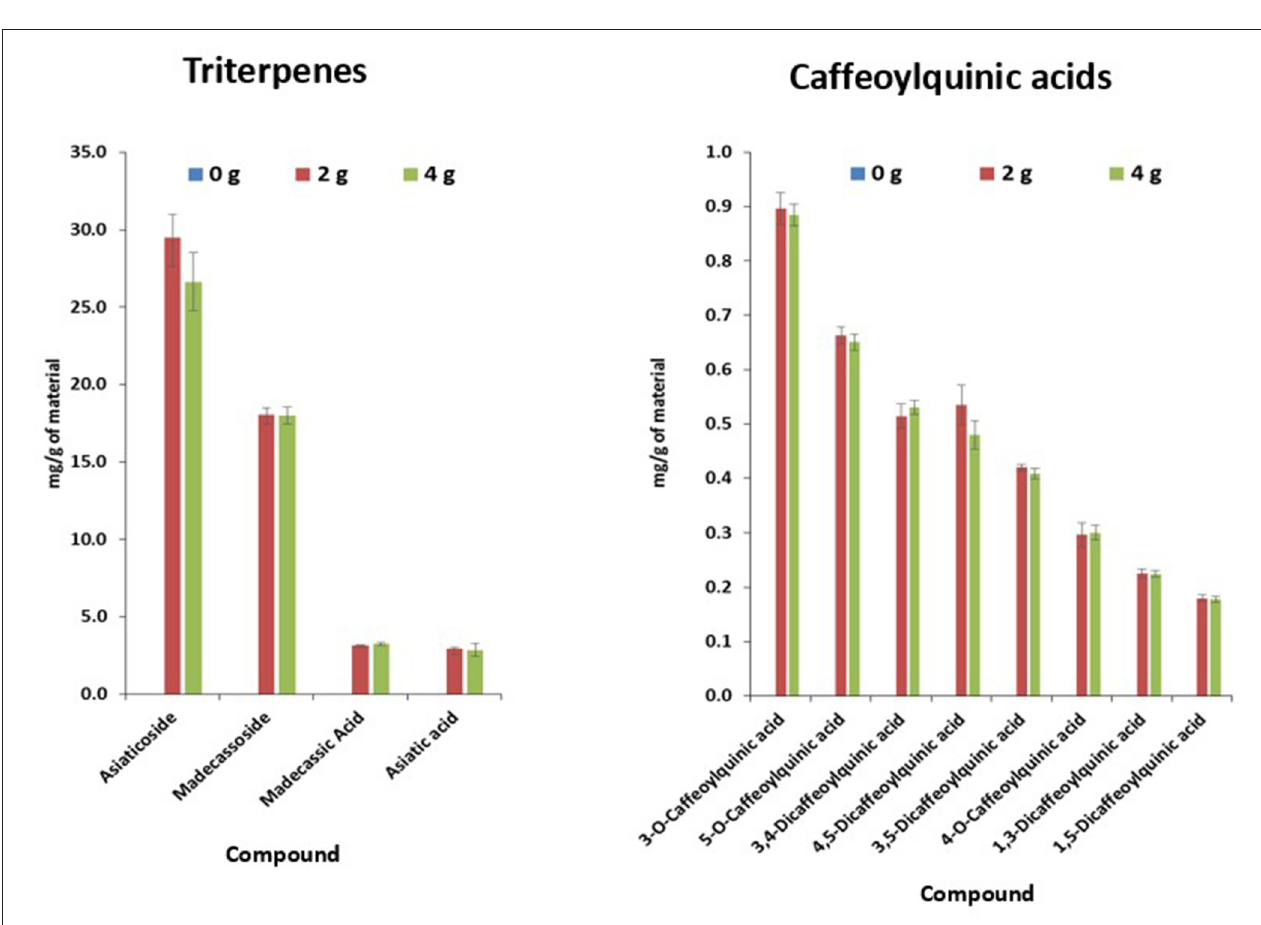
FIGURE 3 | Concentration of triterpenes and caffeoylquinic acids found in 0, 2, and 4g Centella asiatica product as determined by LC-HRMS. Sachets of the Centella asiatica water extract products (CAP; n = 5 per dose) were extracted with methanol and analyzed for the content of active compounds (triterpenes and caffeoylquinic acids) using LC-HRMS in positive and negative ion mode against commercial reference standards. The content of triterpenes and caffeoylquinic acids per gram of Centella asiatica extract was identical for the 2g and 4g doses of CAP and showed low variability indicating successful and uniform manufacture of the two doses. None of the specific analytes were detected in the 0g dose, confirming their absence at detectable levels in the placebo which was comprised solely of the excipients